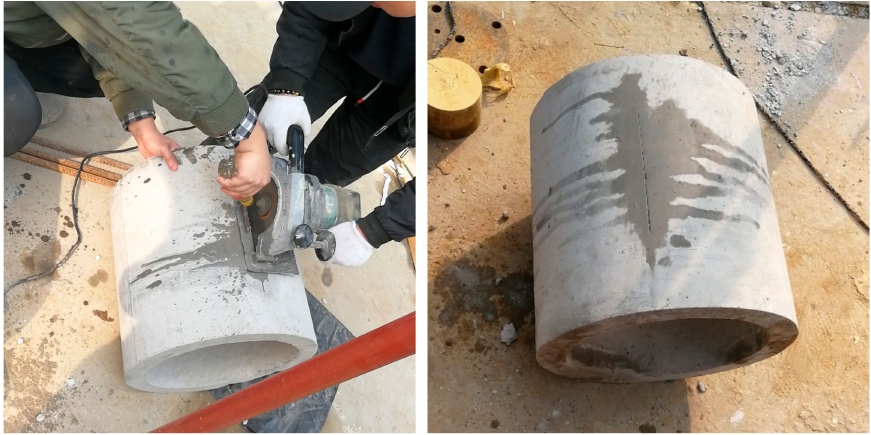
Figure 5. Cutting and forming cracks on the concrete pipe.